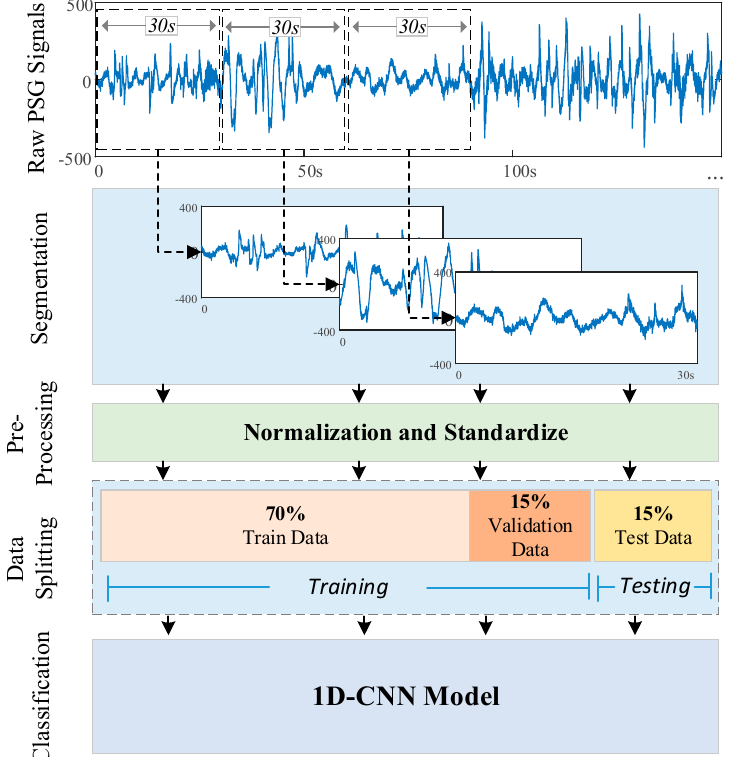
Figure 3. An illustration of experimental steps.